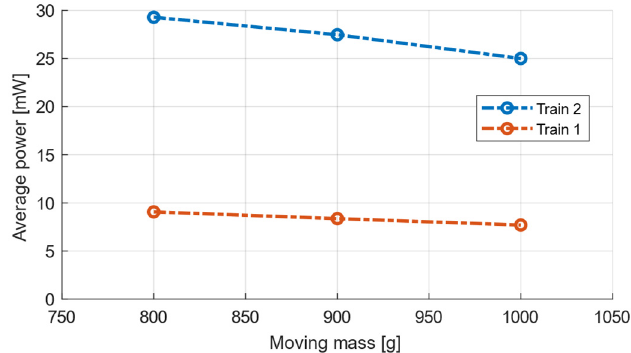
Figure 11. Average power depending on moving mass for Train 1 and Train 2.